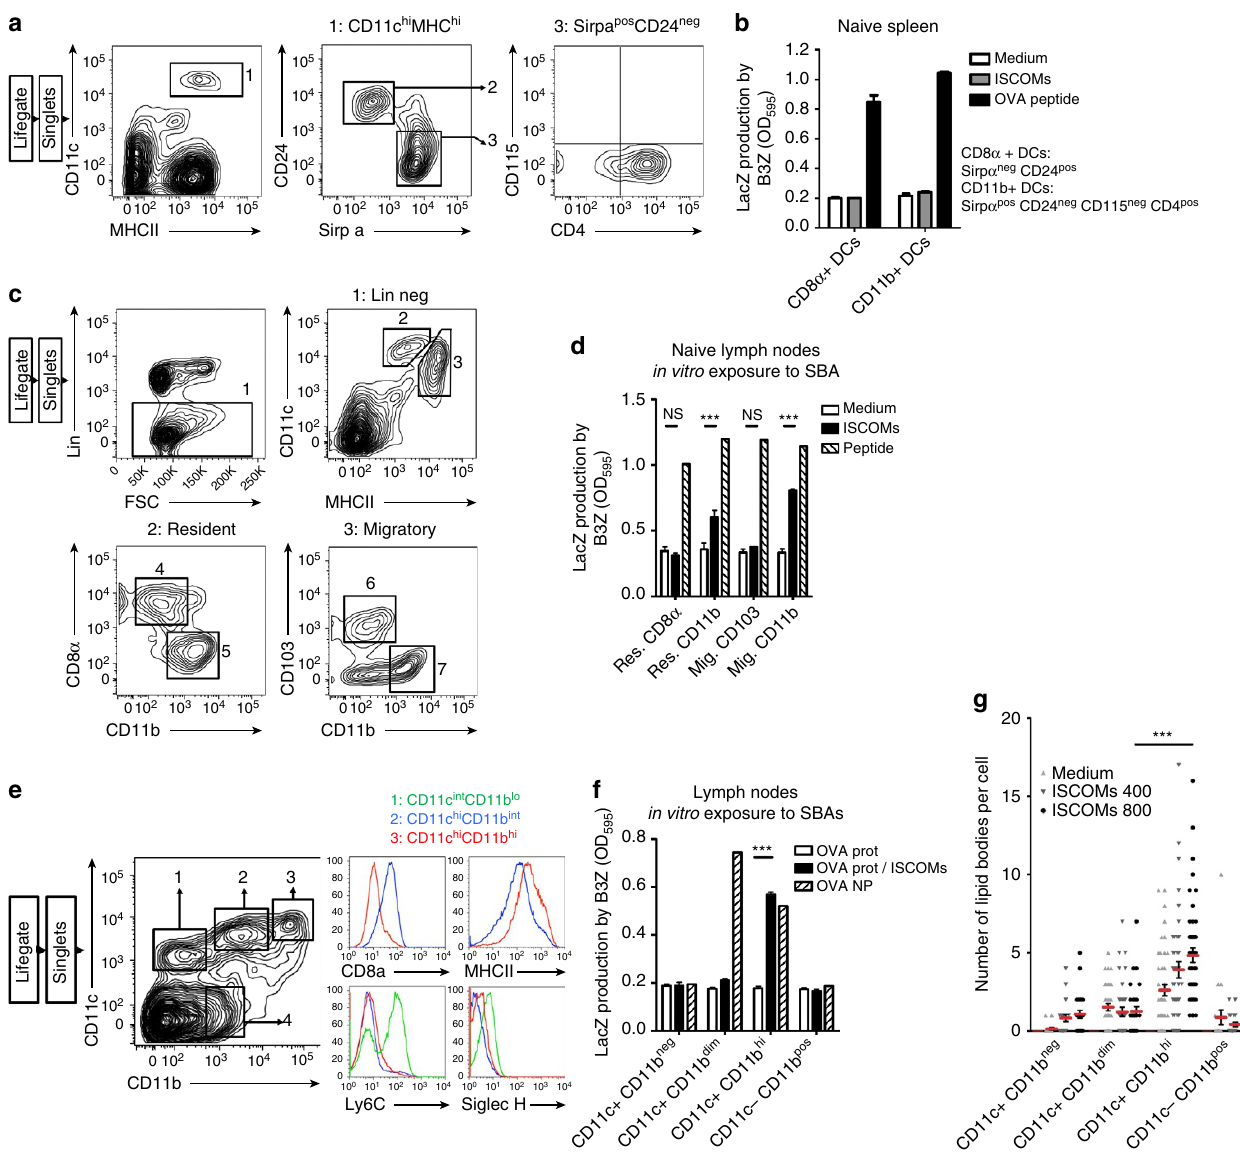
Figure 5 | Lymph node CD11b þ DCs uniquely possess the ability to respond to SBAs in vivo . ( a ) Gating strategy for naive splenocytes. Sorted populations are gate 2 (CD8 a þ DCs) and gate 3 (CD11b þ DCs). ( b ) In vitro cross-presentation assay using the populations as sorted under a . ( c ) Gating strategy for naı¨ve lymph nodes. Lin- was defined as B220- and Ly6G-. Sorted populations are gate 4 (LN resident CD8 a þ DCs), gate 5 (LN resident CD11b þ DCs), gate 6 (LN migratory CD103 DCs), and gate 7 (LN migratory CD11b þ DCs). ( d ) In vitro cross-presentation assay using the populations as sorted under c . subjected to FACS sorting. ( e ) Gating strategy, in which sorted populations are gates 1 to 4. Right panels show additional stainings on populations 1 to 3. ( f ) In vitro cross-presentation assay using populations as sorted under e . Sorted cells were exposed for 5h to the indicated compounds (ISCOMs 800ngml (cid:2) 1 , OVA 300 m gml (cid:2) 1 , PLGA nano-particles corresponding to 30 m gml (cid:2) 1 OVA). ( g ) LB quantification in populations as sorted under e . All data were reproduced in two independent experiments. Statistical analyses were performed using two-way ANOVA with post hoc Bonferroni